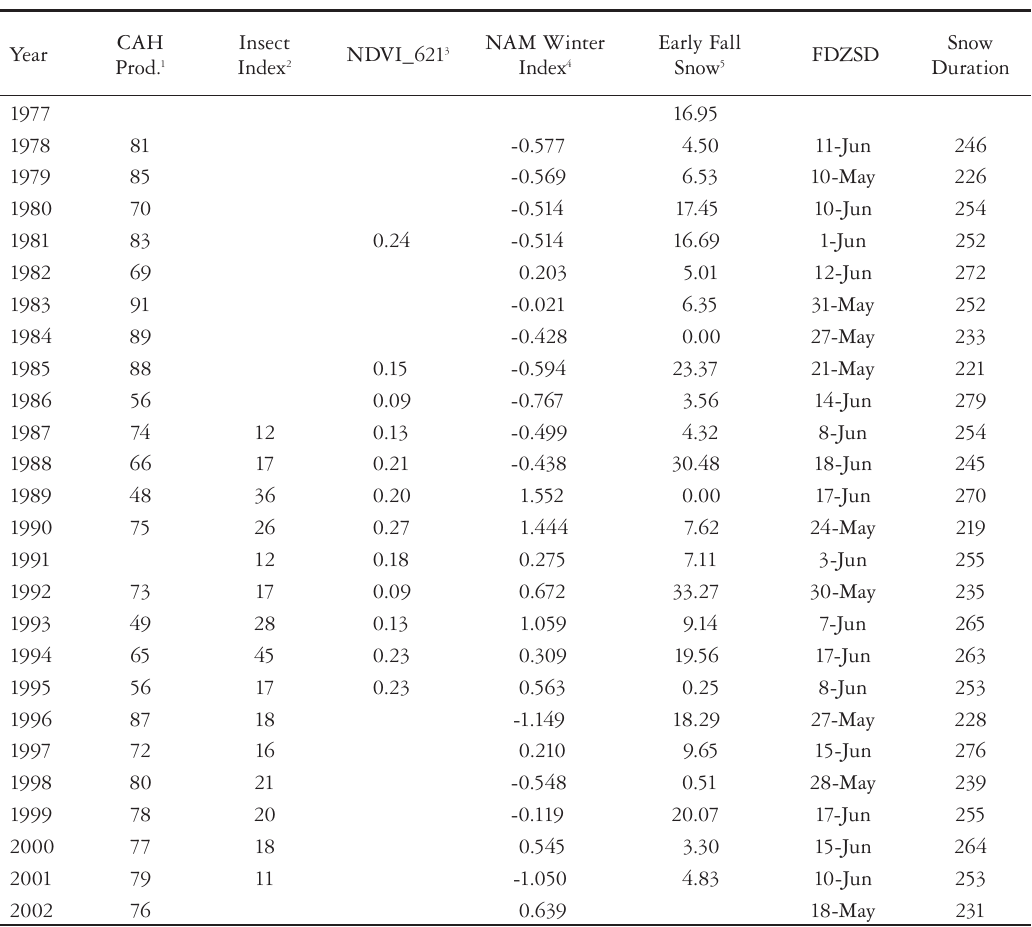
Table 1. Estimates of Central Arctic Herd (CAH) net productivity ~1 week after the peak of calving (# calves:100 cows), summer insect severity (# harassment days from 15 June–15 August), NDVI_621 from the entire CAH calving grounds, NAM winter index, early fall snow from 15 August–30 September (cm), the first day of zero snow depth in the spring (FDZSD), and the number of days from the first one inch of lasting snow from the previous fall through FDZSD,